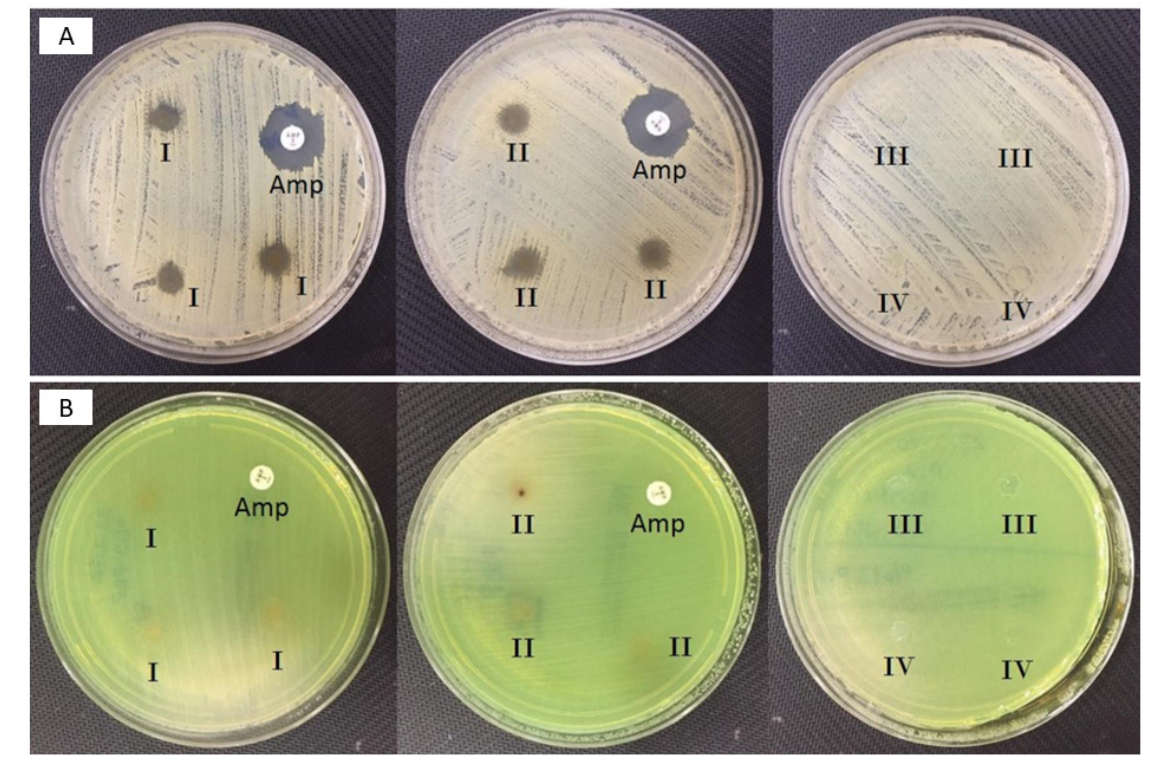
Figure 4. Staphylococcus aureus ATCC 29,213 tested by disk diffusion ( A ); I: 3% propolis containing disk, II: 5% propolis containing disk, III: 13% PVA containing disk, IV: 0.5% gel containing disk. Pseudomonas aeruginosa ATCC 27,853 tested by disk diffusion ( B ); I: 3% propolis containing disk, II: 5% propolis containing disk, III: 13% PVA containing disk, IV: 0.5% gel containing disk.